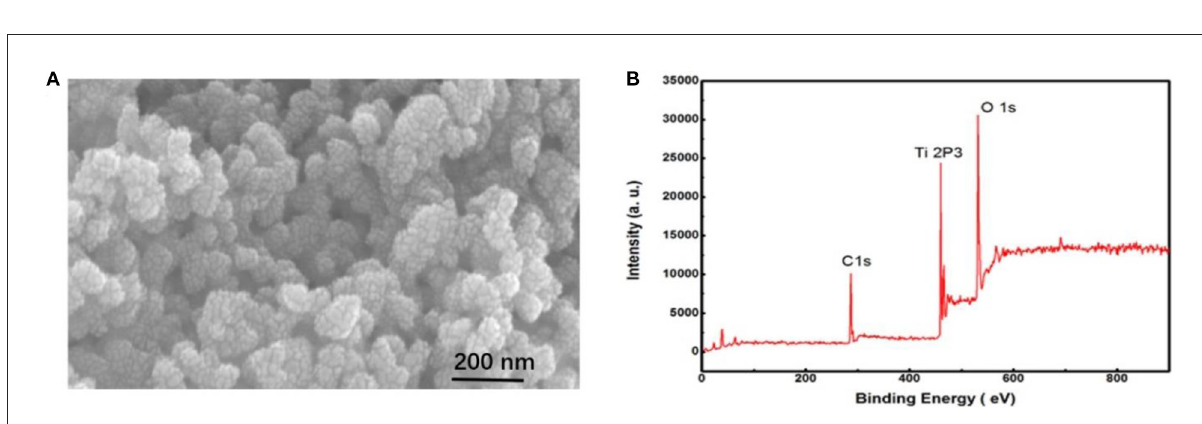
was I = 54.6749 + 2.4651 logC ( R = 0.99525) (Figure 4). The minimum detection concentration limit for RABV is ∼ 2.16